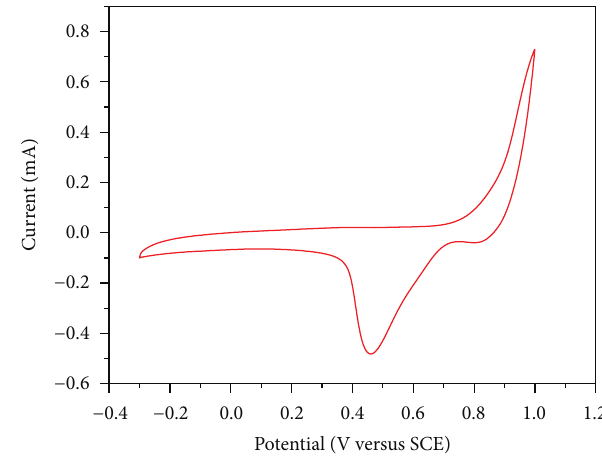
Figure 4: Cyclic voltammograms detailing response of a bare Au electrode to 200 𝜇 M Cr(VI) in 0.1 M HCl (scan rate = 50 mVs −1 ).